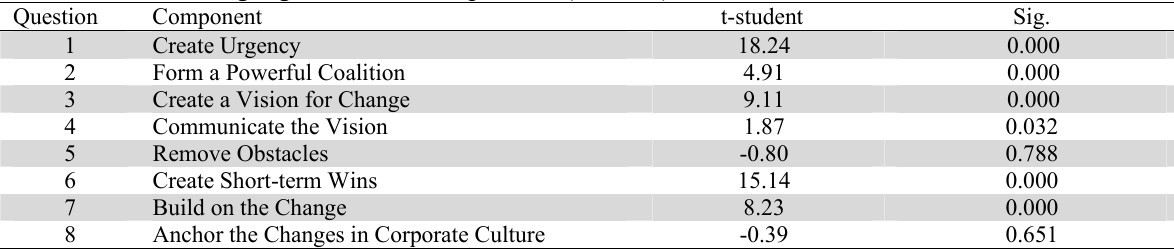
The results of testing eight Kotter’s components (df =152)